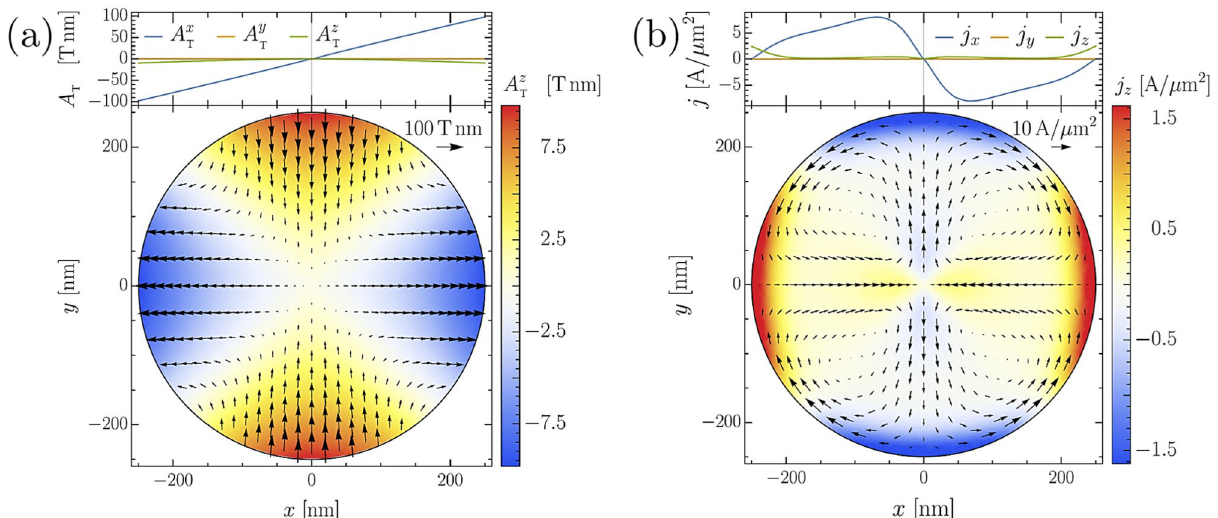
Figure 4. ( a ) The calculated vector potential for the STEs metastructure shown in Fig. 1 at the position of the SC sample. ( b ) The total current density ( b ) in the superconductor in the process of ramping up the fields at 0.5 ps (upper insets show the dependence in the x direction at y 0 and t z = =